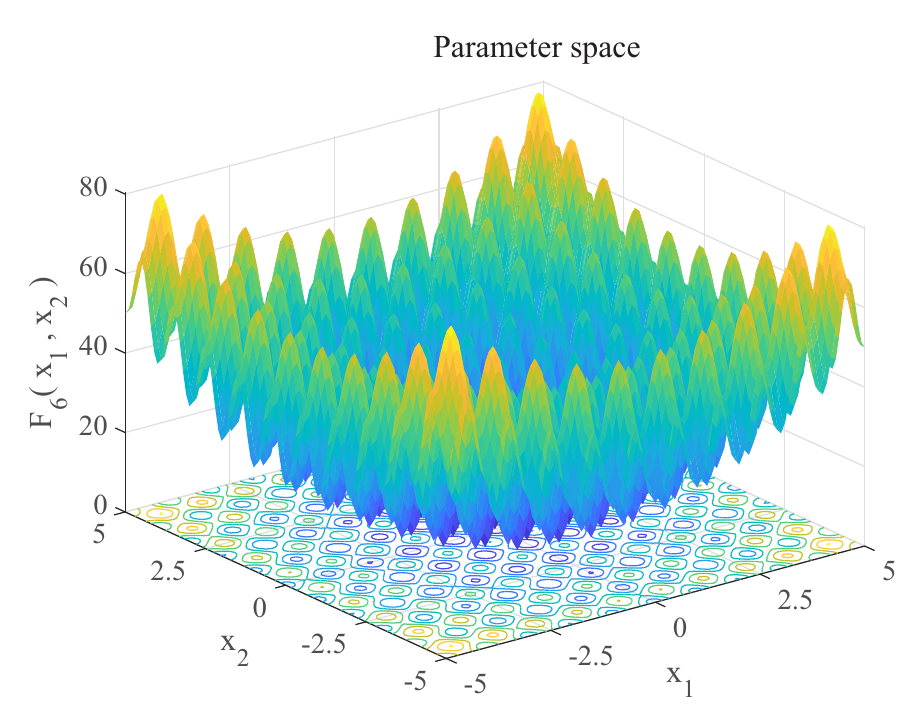
Fig 7. Three-dimensional graph of F 6 ( x ).